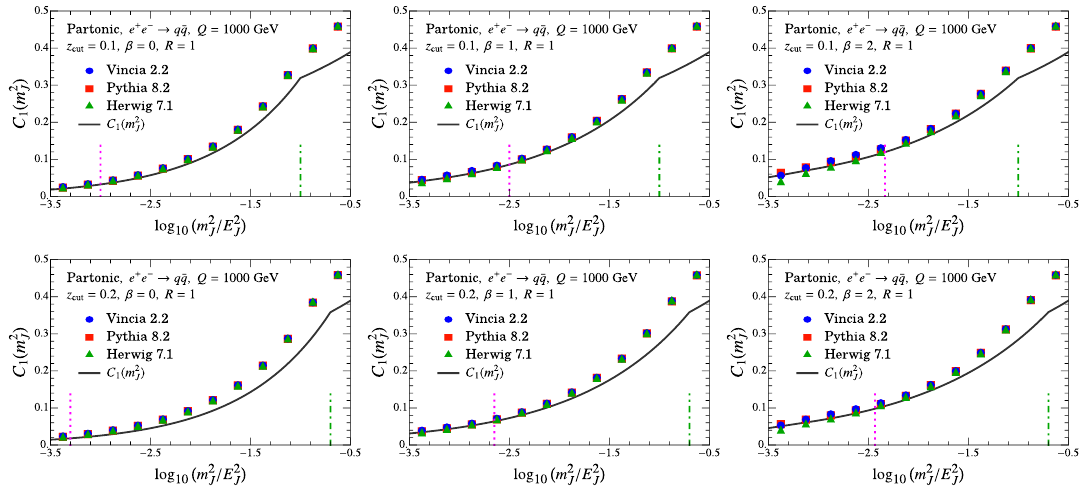
) with partonic Monte Carlo for z cut = 0 : 1 ; 0 : 2 J